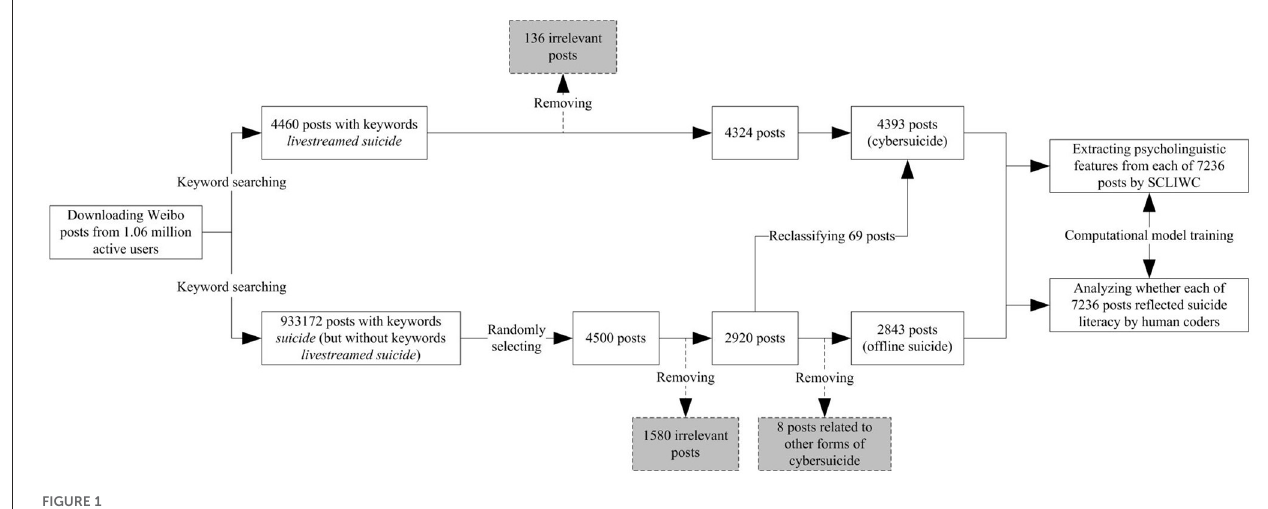
FIGURE1 The research process.